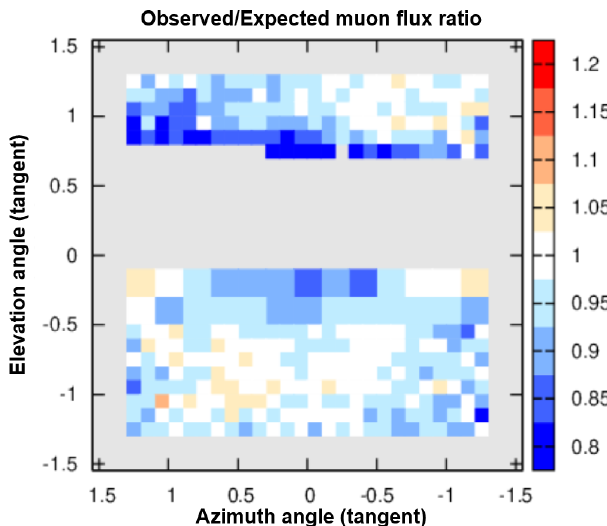
Figure 14. Example of the observed / expected muon flux ratio in the free sky region at site N. The horizontal axis represents the az- imuth angle, and the vertical axis represents the elevation angle. Positive elevation angle means the muons come from forward direc- tions (the volcanic cone). Negative elevation angle means the muons come from backward free sky directions. The typical deviation of the ratio is 4%–7% in each